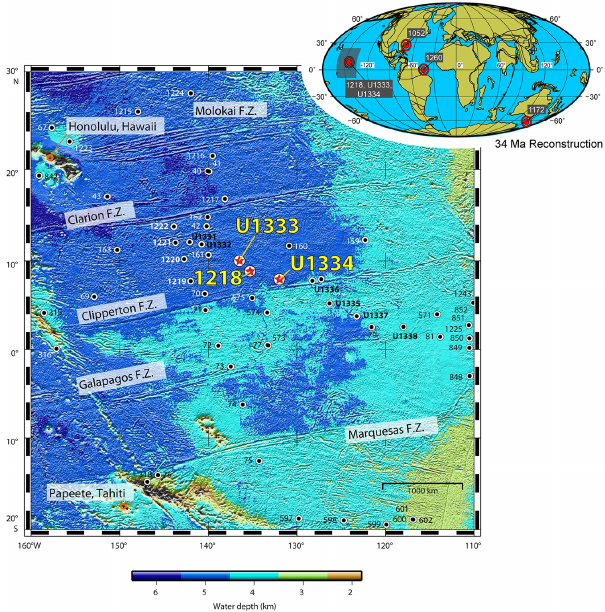
Figure 1. Location map of sites used in this study on 34Ma pale- ogeographic reconstruction in Mollweide projection (ODSN, 2011; Hay et al., 1999) and detailed location map in the Pacific (big map, red stars) with additional IODP/ODP/DSDP sites. F.Z. = fracture zone (modified from Pälike et al.,